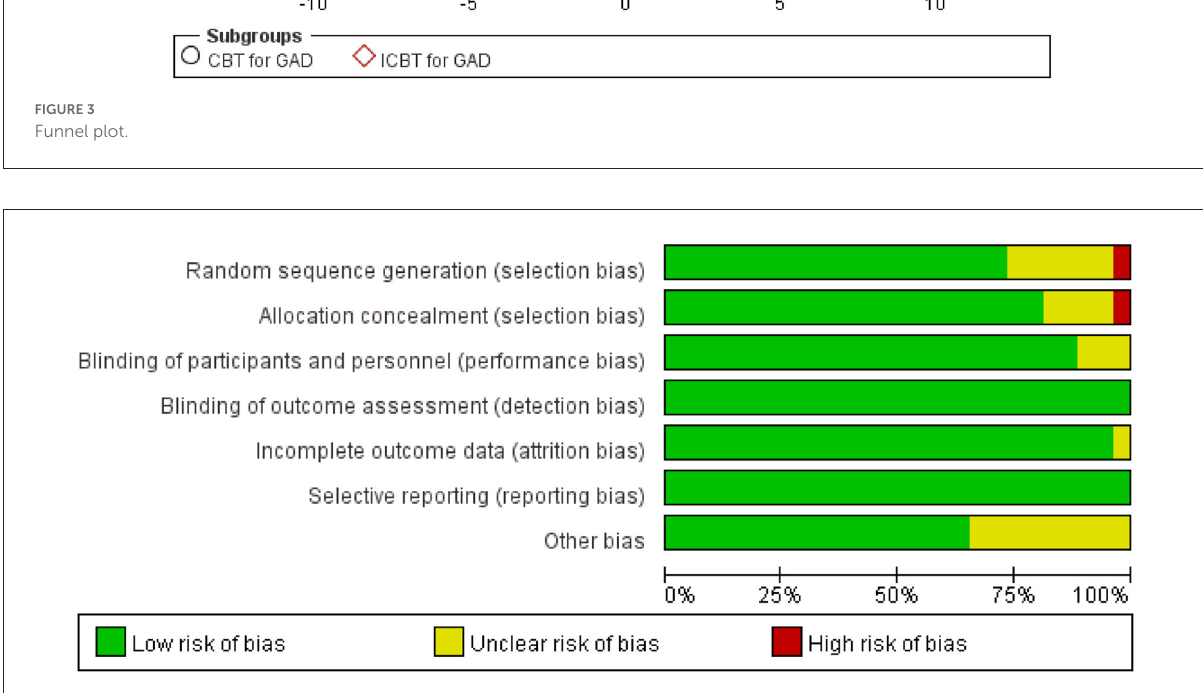
FIGURE4 Risk of bias